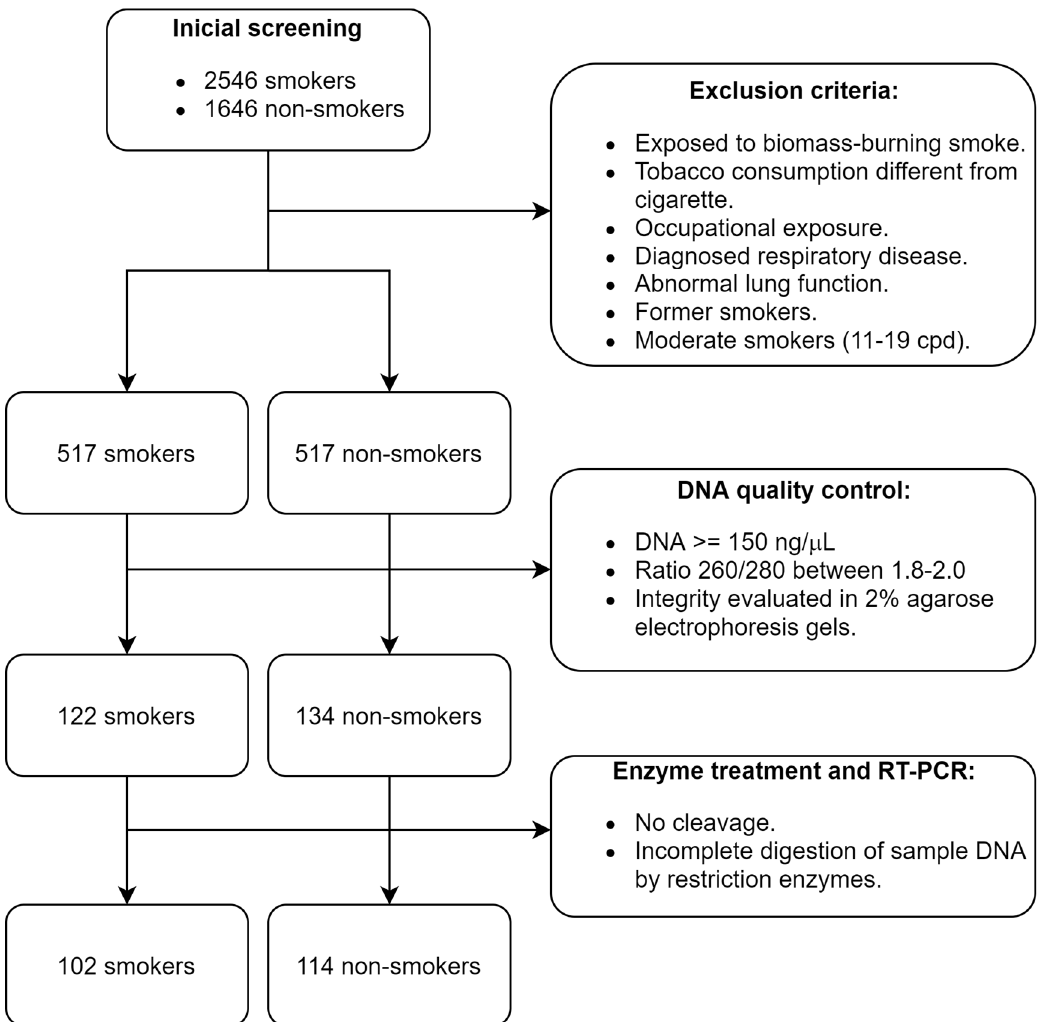
Figure 1. Patient selection process according to the STREGA guidelines